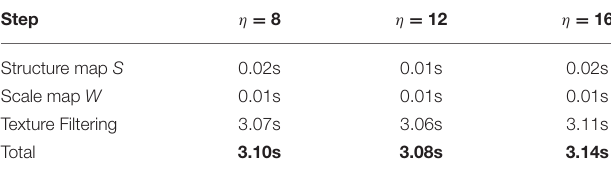
TABLE 2 | Timing statistics for a single iteration of a color